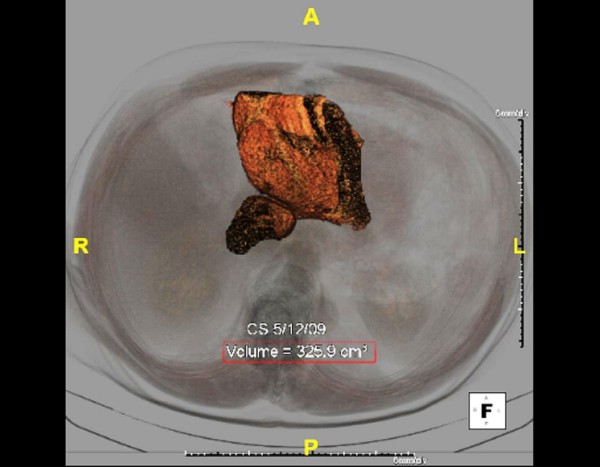
Three Dimensional(3-D) Reconstruction of Small FLR with calculated volume measurements. Patient(as in Figure 1, 2) with metastatic rectal carcinoma and right hepatic metastasis with small FLR with radiologically calculated volume of 325.9 cm2. Using standardized volumetric formulas, this patient had a FLR of approximately 19%.